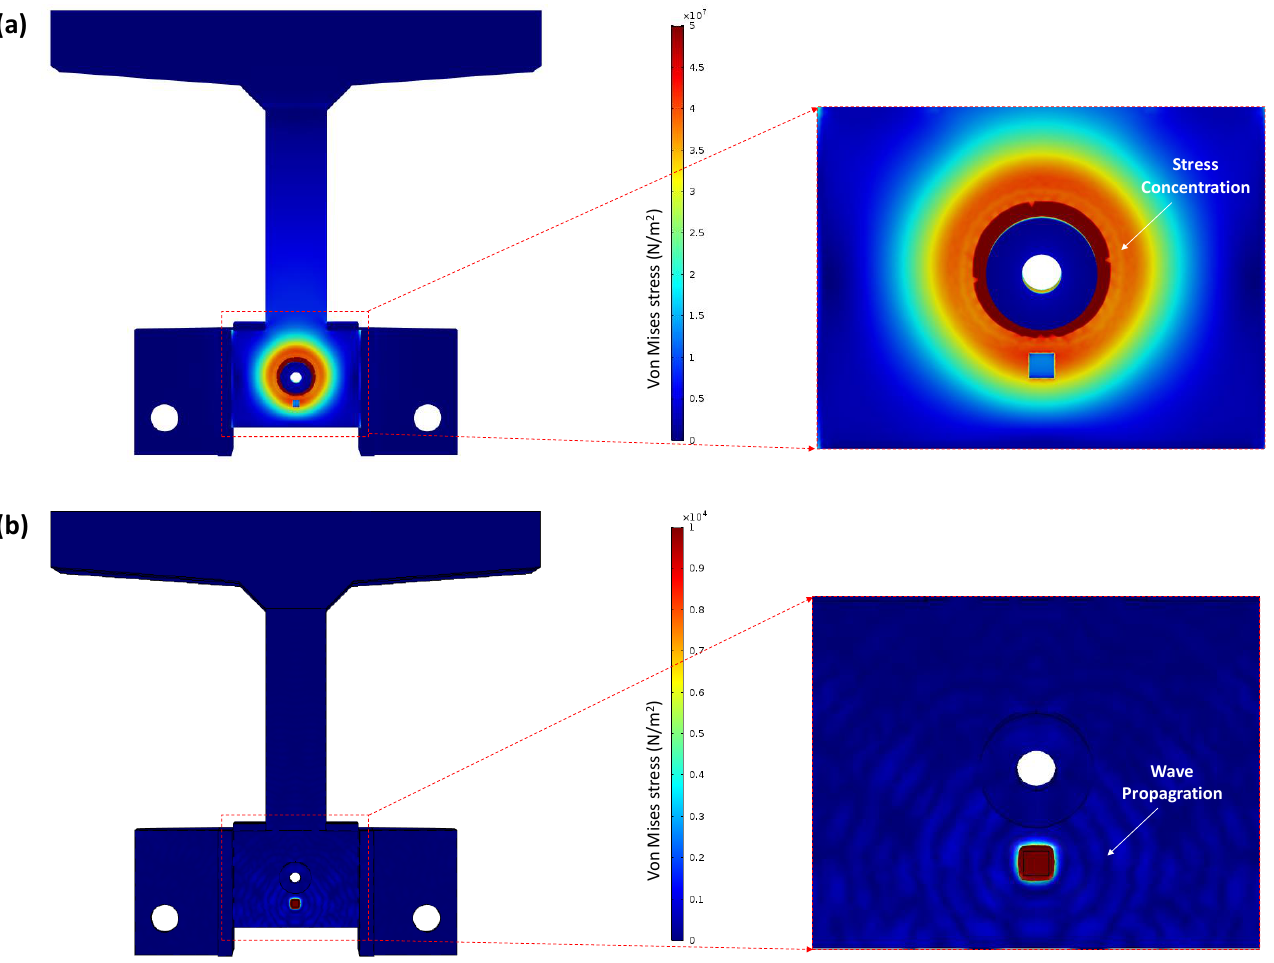
Figure 5. Von Mises stress under ( a ) prestress load and ( b ) PZT’s excitation at 140 kHz.